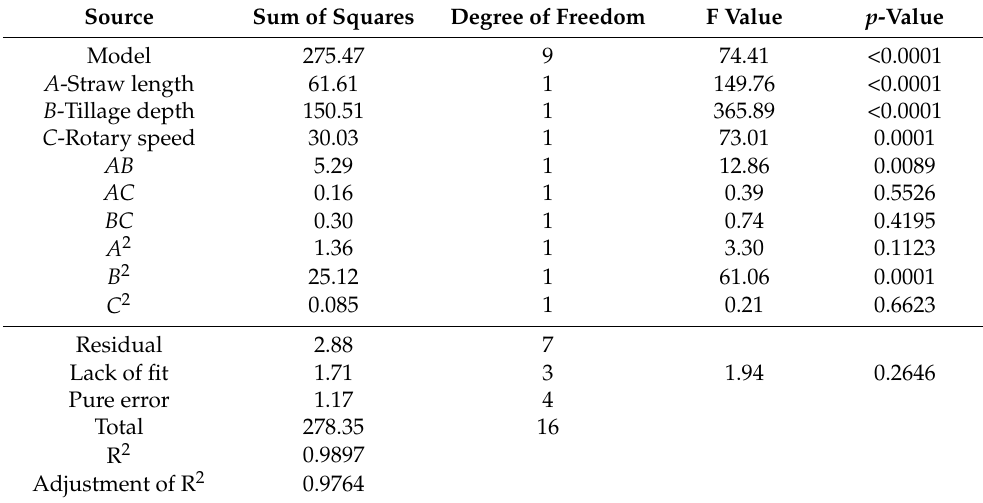
Table 4. Variance analysis of straw displacement.